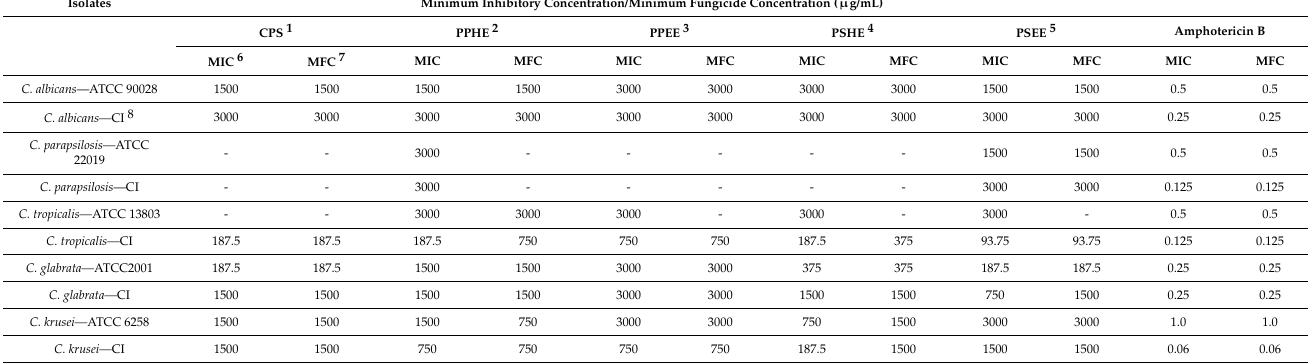
Table 1. Minimum inhibitory concentration and minimum fungicide concentration of the hexane and ethanolic extracts from Capsicum chinense Jacq. peel and seeds, capsaicin, and amphotericin B against Candida